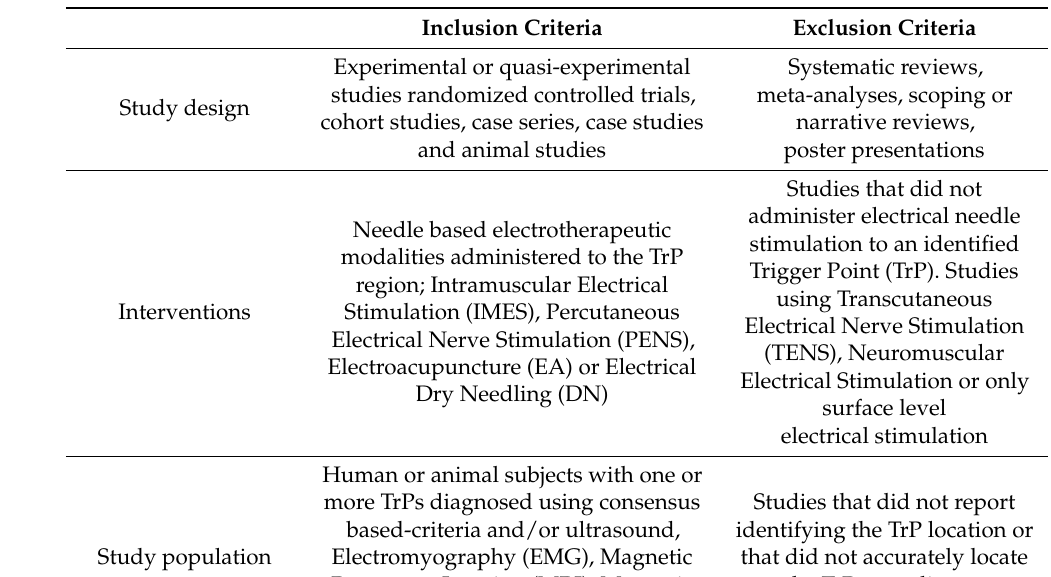
Table 2. Inclusion and exclusion